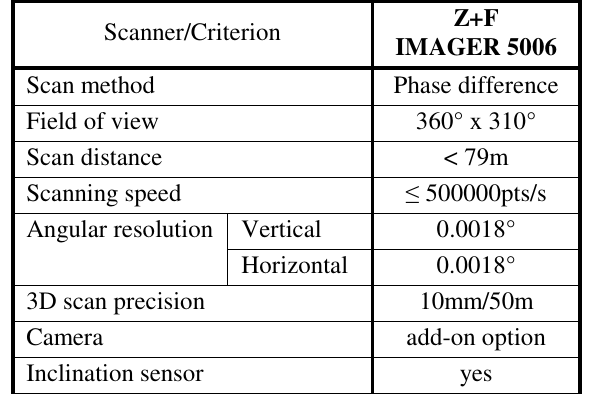
Figure 4: Coloured point cloud of the IMAGER 5006 using the images of the Nikon D200, which was mounted on the nodal point adapter, in